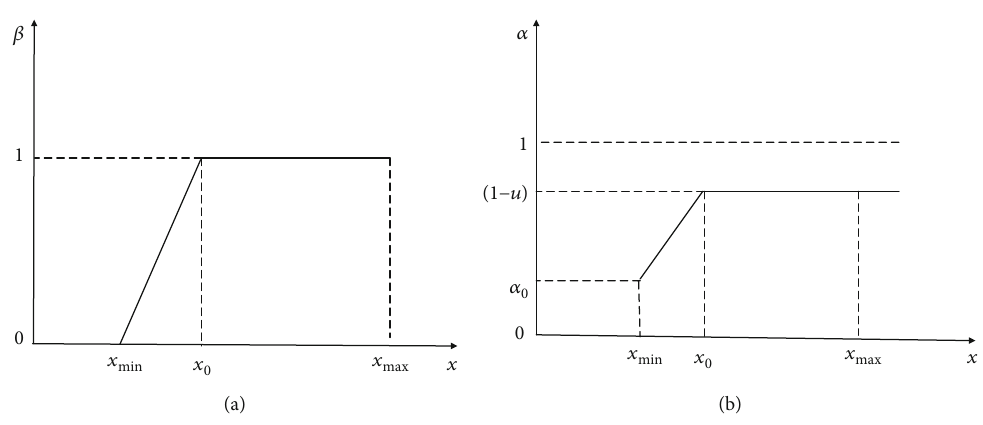
Figure 1: The graph of membership functions β and α